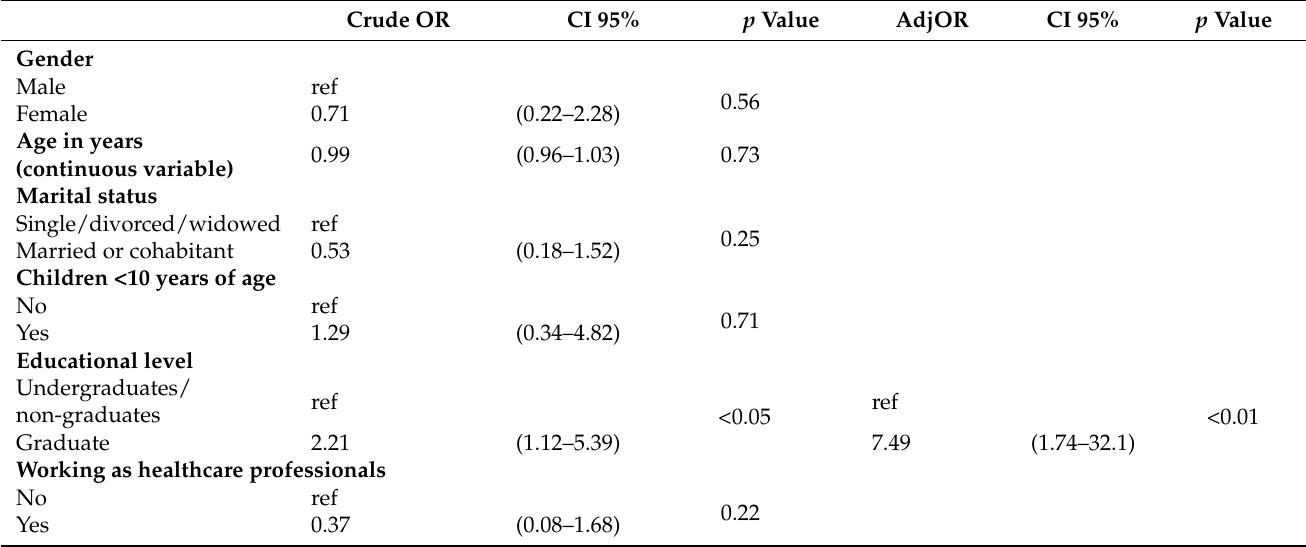
Table 5. Crude odds ratio (OR) and adjusted OR (AdjOR) for sociodemographic, lifestyle, and clinical characteristics, knowledge, attitudes, and perceptions about general vaccination, with positive attitudes towards vaccines in patients with celiac